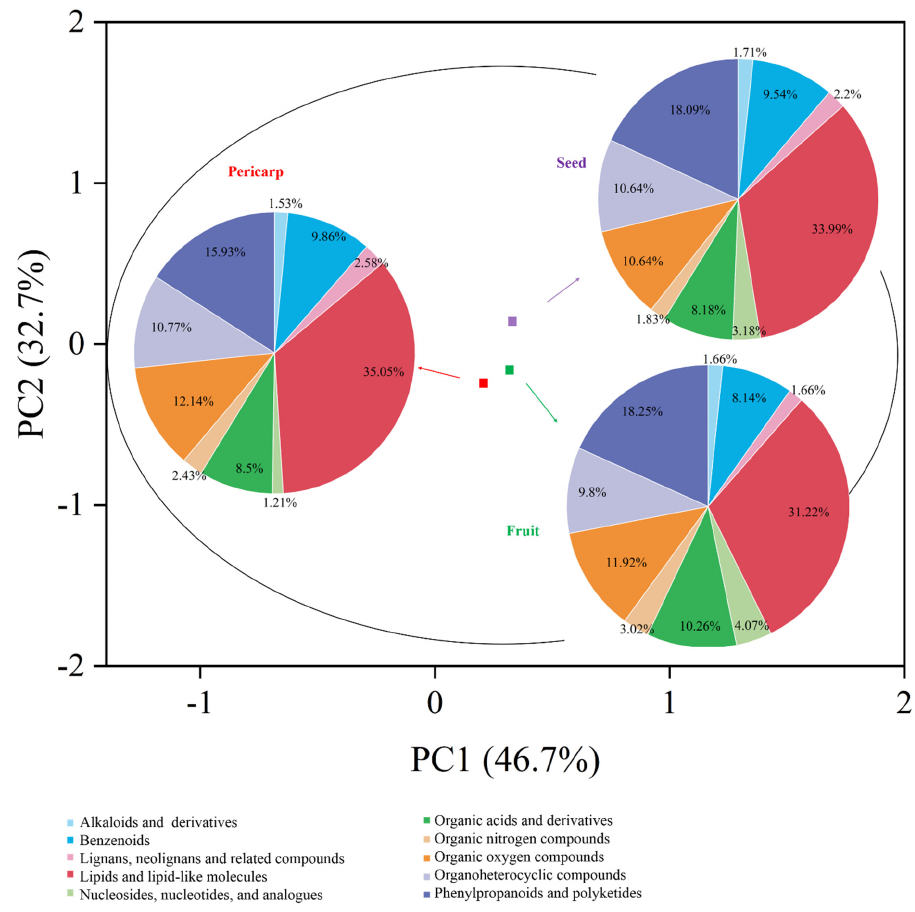
Figure 1. PCA plot of A. trifoliata fruit, pericarp, and seed extracts. PC1 (46.7%), PC2 (32.7%). Within the PCA plot, fruit extract is represented in green, pericarp extract in red, and seed extract in purple. Different classes of compounds identified in each sample are represented using a pie chart.